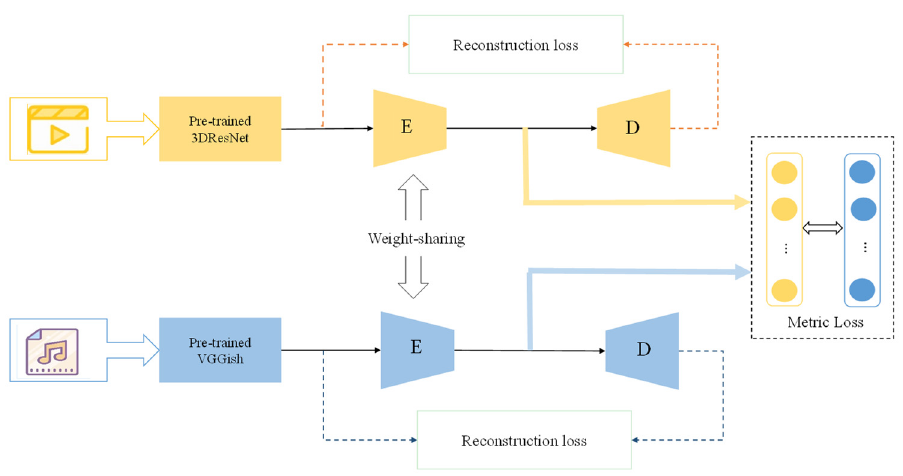
Figure 2. Overview of the proposed content common network. E denotes encoder structure, and D denotes decoder structure. The content common network consists of an encoder–decoder structure as a common representation space in which the weights of the network parameters of the encoder are shared. The content loss include reconstruction loss in the encoder–decoder structure and metric loss between the two modalities of information.